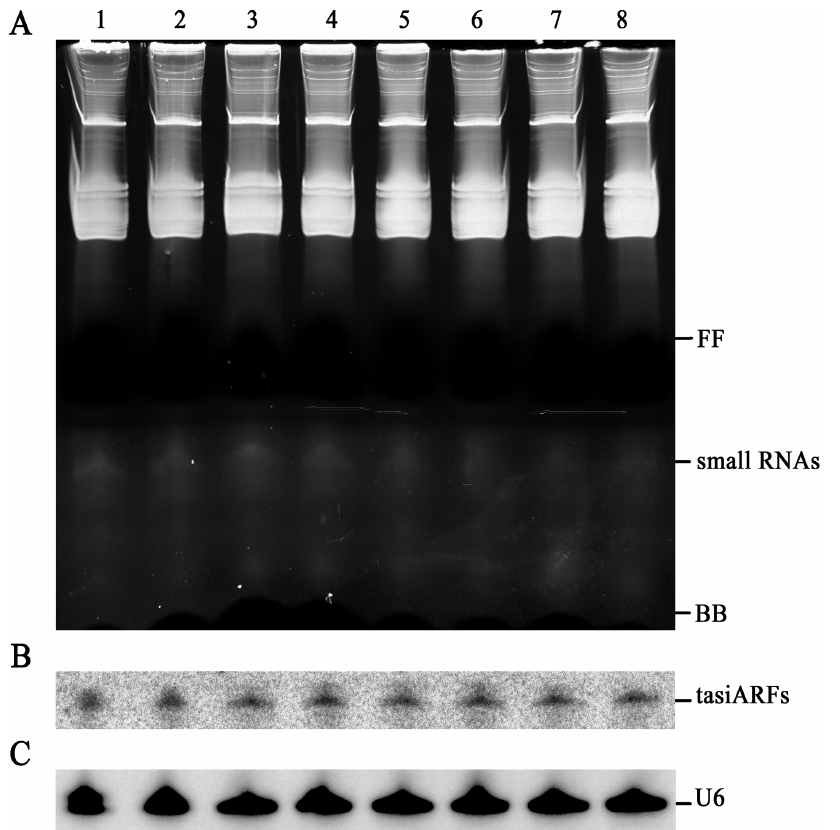
Figure 5. Analysis of putative conserved tasiARFs extracted from several tropical and subtropical plants. (A) Gel electrophoresis of LMW RNAs (100 m g) from different tropical and subtropical plant leaves. (B) Northern blot assay of putative conserved tasiARFs with a complementary 42-nt probe. (C) U6 snRNA hybridization is shown as a loading control. Lanes 1–8 represent guava, banana, citrus, pineapple, longan, lychee, rubber and cactus, respectively. FF: band of xylene cyanol FF; BB: band of bromophenol